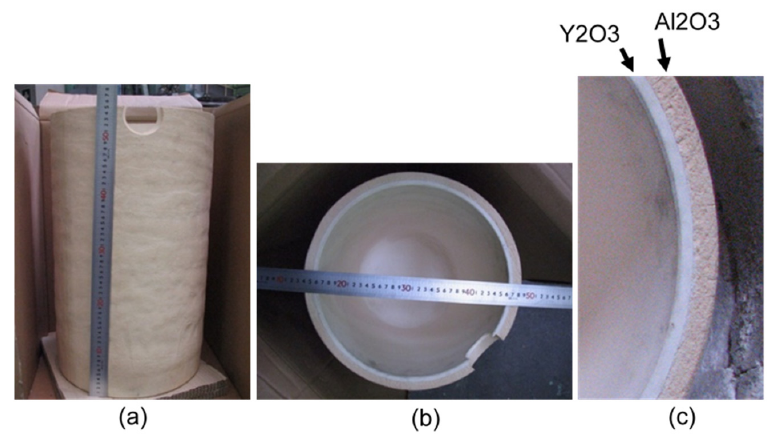
Figure 7. Ceramic crucible used to melt large ingots. ( a ) Overall appearance, ( b ) top surface, and ( c ) enlargement of the top surface.